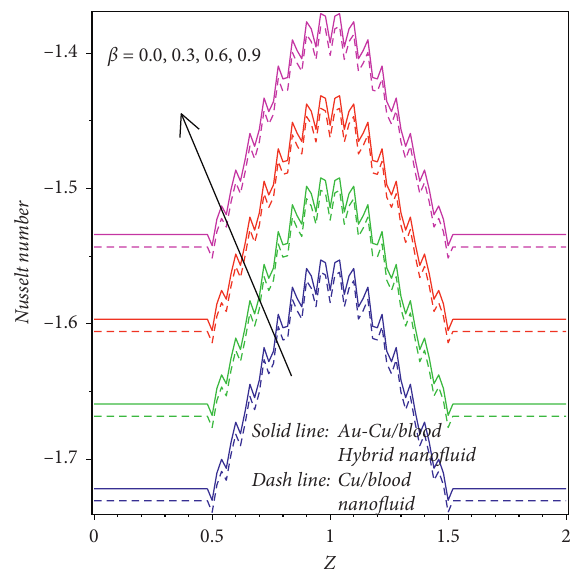
+ ϕ and ϕ on Nu ∗ at Z . 1 2 2